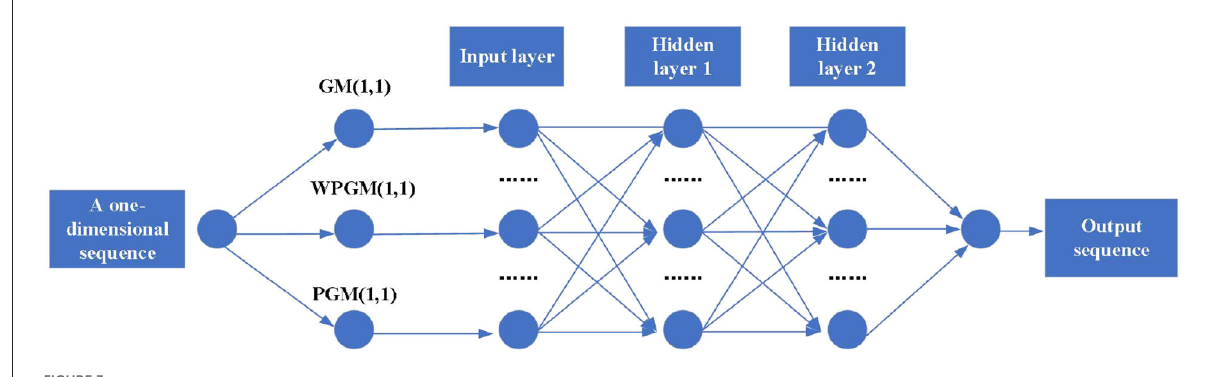
FIGURE3 The topology of gray neural network prediction